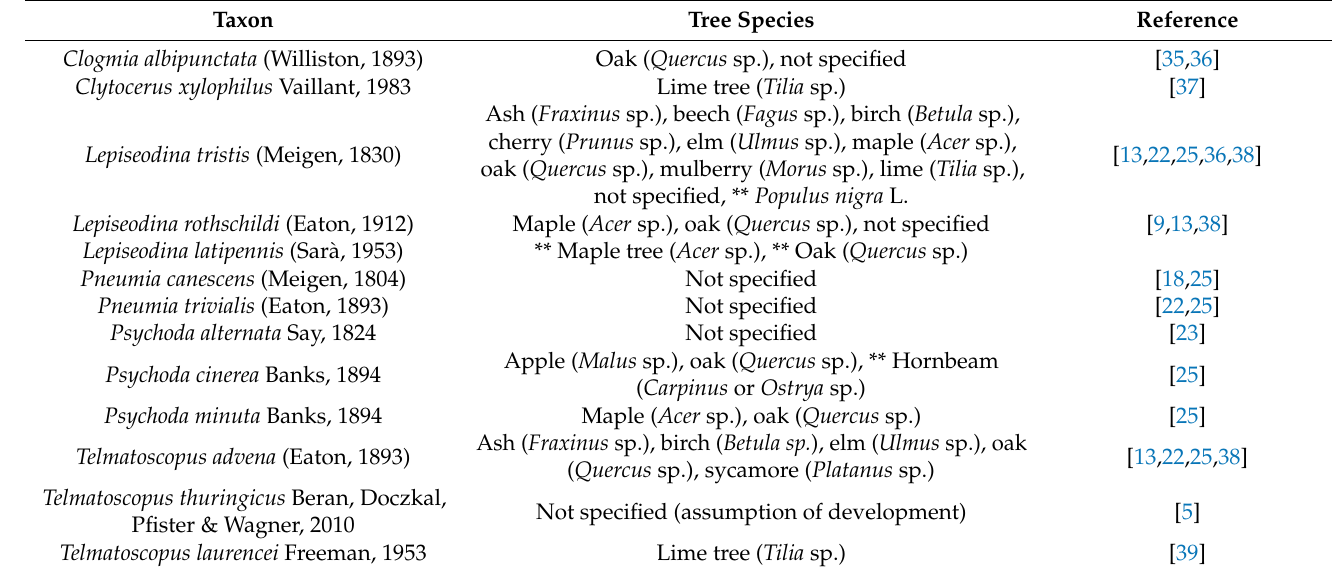
Table 1. Dendrolimnetic Psychodinae taxa reported for Europe, tree species where it was reported and references. Double asterisk (**) denotates a new record of tree species for the Psychodinae